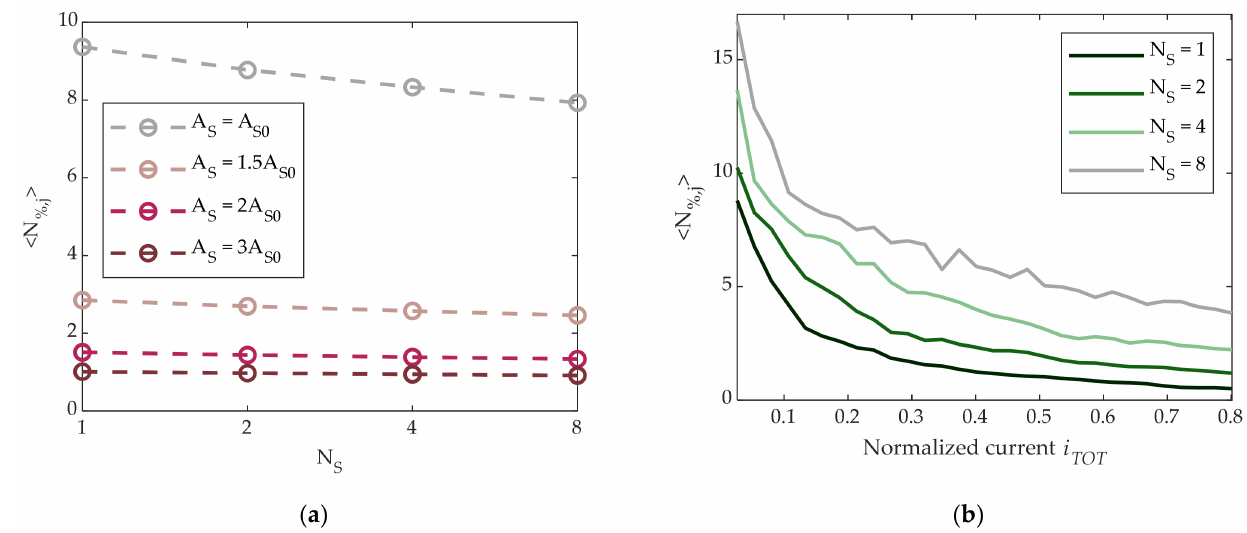
(cid:68) (cid:69) N %, j of N %,j defined in (3) vs. number N S of samples in the averaging window (cid:68) (cid:69) N %, j vs. normalized total current for different N S